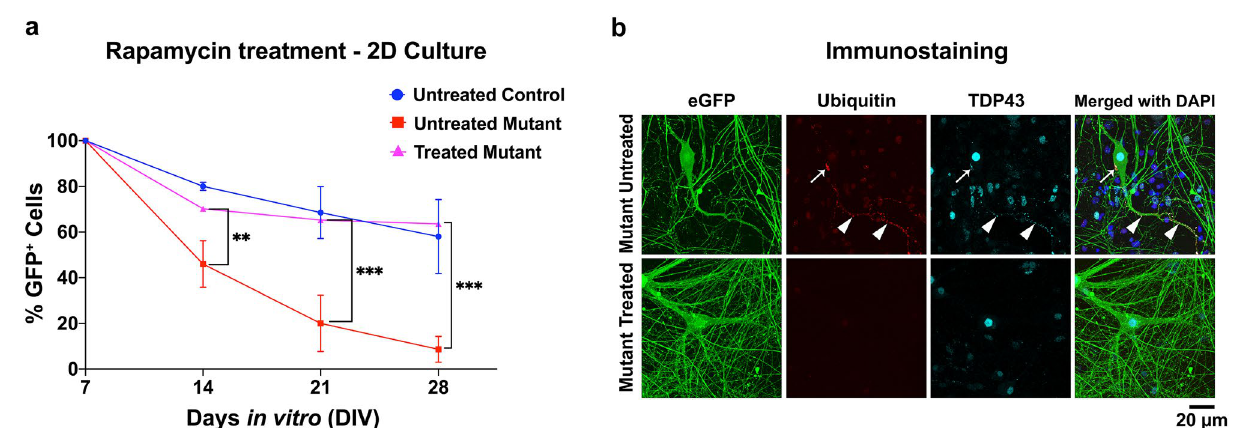
Figure 5. Rapamycin assay in 2D culture. ( a ) Mutant (A315T) MNs show an increase in survival when treated with 1 µM of rapamycin with %GFP + cells equivalent to those of control at 21DIV and 28DIV. Mutant MNs not treated with rapamycin show a rapid decrease in survival from 7 to 28DIV compared to the control MNs(Untreated Control). All fluorescent intensities were normalized to 100% at 7 DIV. ( b ) Immunostaining of treated and untreated mutant MNs for cytosolic TDP-43 and Ubiquitin showing the reduction/absence of the cytosolic aggregates in the treated samples compared to that of untreated samples (arrows are indicating the cytosolic aggregates). P values: Non significant (ns) P > 0.05, *P ≤ 0.05, **P ≤ 0.01, ***P ≤